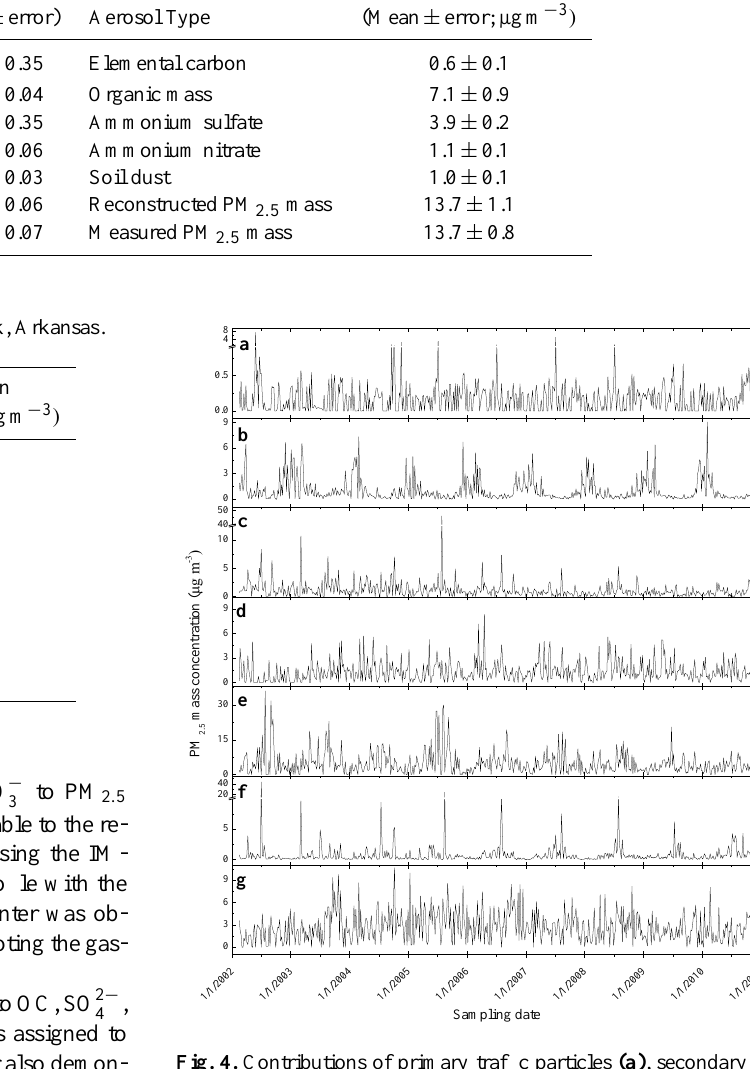
Figure 4. Contributions of primary traffic particles (a), secondary nitrate (b), diesel emissions 2 Fig. 4. Contributions of primary traffic particles (a) , secondary ni- (c), aged sea salt (d), secondary sulphate (e), mineral dust (f) and biomass burning (g) on 3 trate (b) , diesel emissions (c) , aged sea salt (d) , secondary sulphate PM 2.5 mass in Little Rock, Arkansas. 4 (e) , mineral dust (f) and biomass burning (g) on PM 2 . 5 mass in Lit- tle Rock,